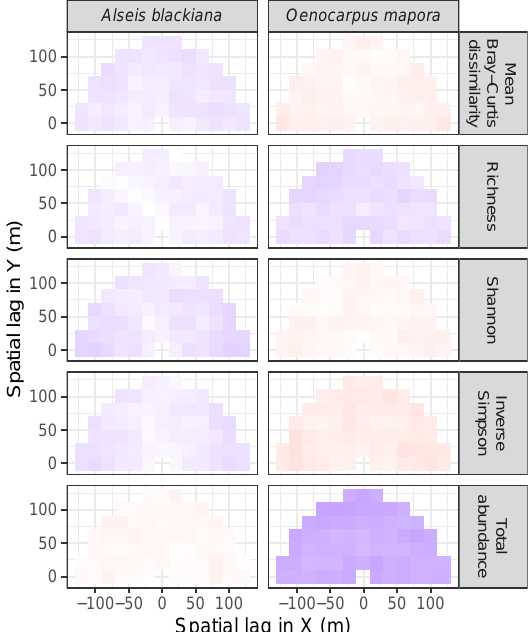
Figure 16. Codispersion between measures of diversity and total basal area of the two focal tree species in 20 × 20-m subplots in the 50-ha BCI plot. Codispersion coefficients were calculated for spatial lags ranging from 0–125 m at 20-m intervals. The value of the codispersion coefficient can range from (dark blue) through 0 (white) to 1 (dark red). Statistical significance of each codispersion coefficient is shown in Figure 19 and Figure A4.